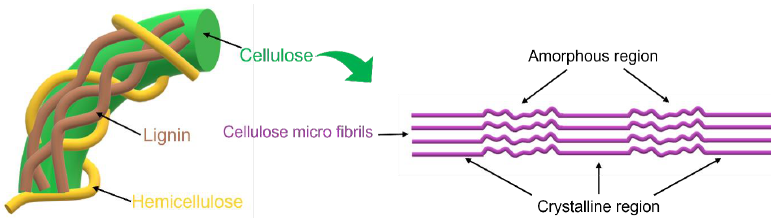
Figure 1. Amorphous and crystalline regions of cellulose micro fibrils.